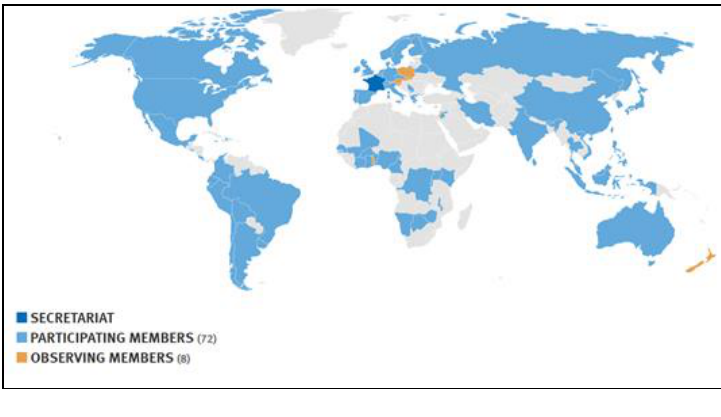
Figure 1: ISO/TC 323 Circular Economy Worldwide Participation